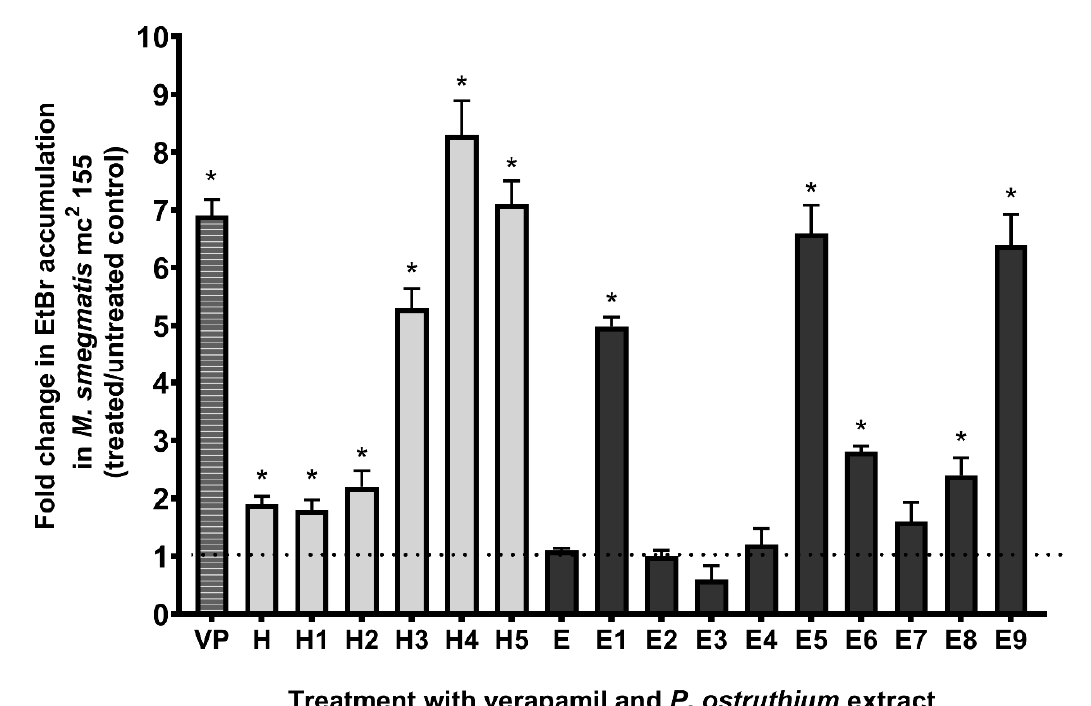
Figure 3. Fold change in ethidium bromide (EtBr) accumulation in M. smegmatis mc 2 155 culture treated with a sub-inhibitory concentration of 0.25 × MIC of P. ostruthium hexane (H) and ethanol (E) extract and their fractions (H1-H5 and E1-E9), and the known EPI verapamil (VP), compared to untreated control at 60 min treatment time point. The dotted line presents no change in EtBr accumulation fold change (baseline). * p < 0.05.